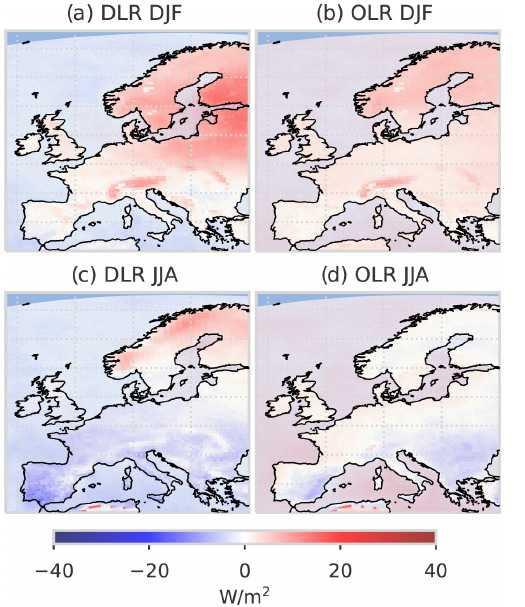
Figure 6. Differences between CARBON and GRASS for DLR (a, c) and OLR (b + d) for the winter season (a, b) and the summer season (c, d) over the period